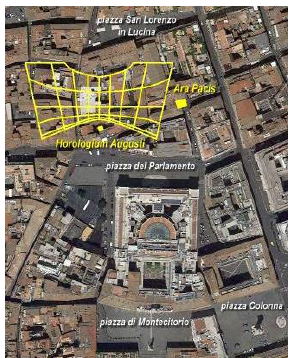
Figure 1: Position of the Solarium Augusti and location of the obelisk in today's Rome